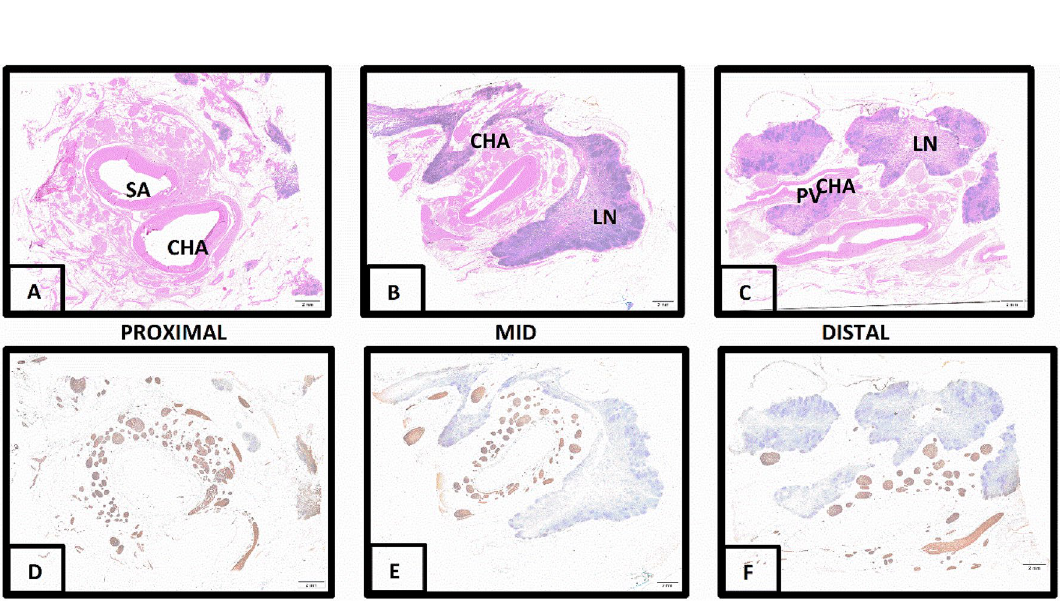
Figure 1. Longitudinal characterization of a representative common hepatic artery. Proximal, middle, and distal segments shown with H&E stain ( A – C ) and corresponding TH immunohistochemistry ( D – F ). H&E staining shows segments beginning just distal to splenic artery (SA) bifurcation. Prominent lymph nodes (LN) are present in ( B ) and ( C ). Portal vein (PV) branch is indicated. TH staining is strong and diffuse (brown color) within all nerve bundles. No ganglia are present. A 2 mm scale bar was used for all 6